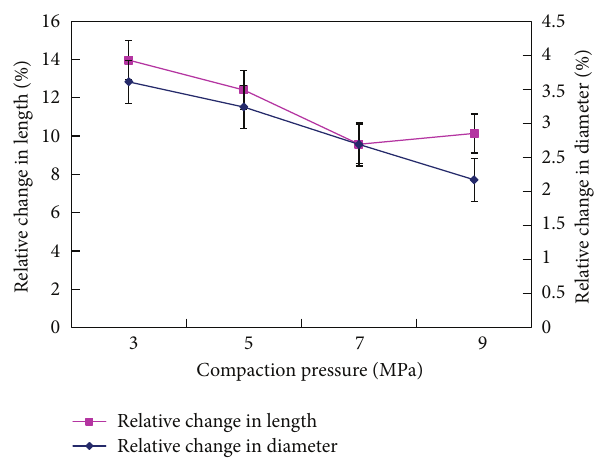
Figure 3: Effect of compaction pressure on relative change in length and diameter of briquettes.